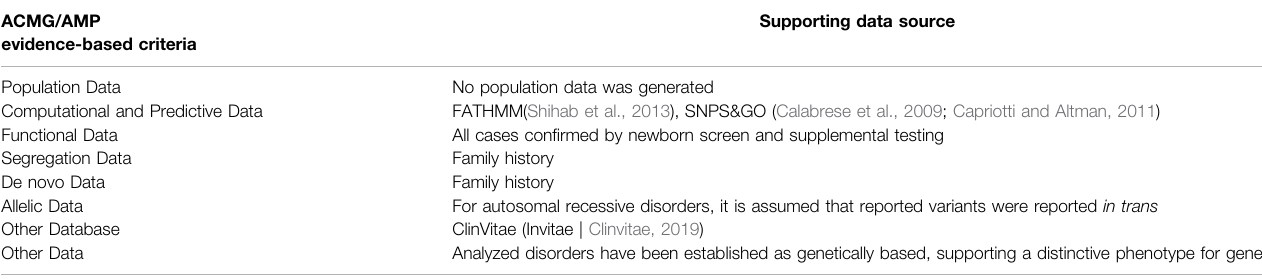
TABLE 1 | Variant classi fi cation criteria and supporting data Source(s). The ACMG/AMP Evidence-Based Criteria (Richards et al., 2015) was used to determine supporting data sources. No supporting data was generated for the “ Population Data ” criteria de fi ned by the ACMG/AMP guidelines. Supporting data for other evidence-based criteria werefoundusing computationaltools(Calabreseet al.,2009;Capriotti andAltman,2011;Shihab et al.,2013),withinin thelong-termfollow-updataset (Segregation Data, De novo Data), reported by other databases (Invitae | Clinvitae, 2019), or assumed from the nature of newborn screening/the disease (Functional Data, Other Data).